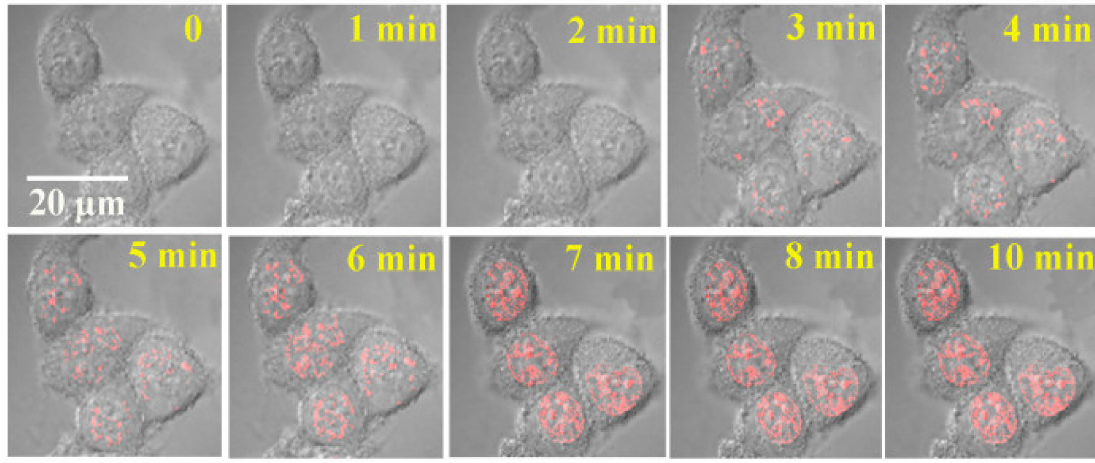
Figure 6. The fluorescent foci from G-quadruplex specific IMT probe (4 µ M) as seen in live HeLa cells with time lapse CLSM. (adapted with permission from